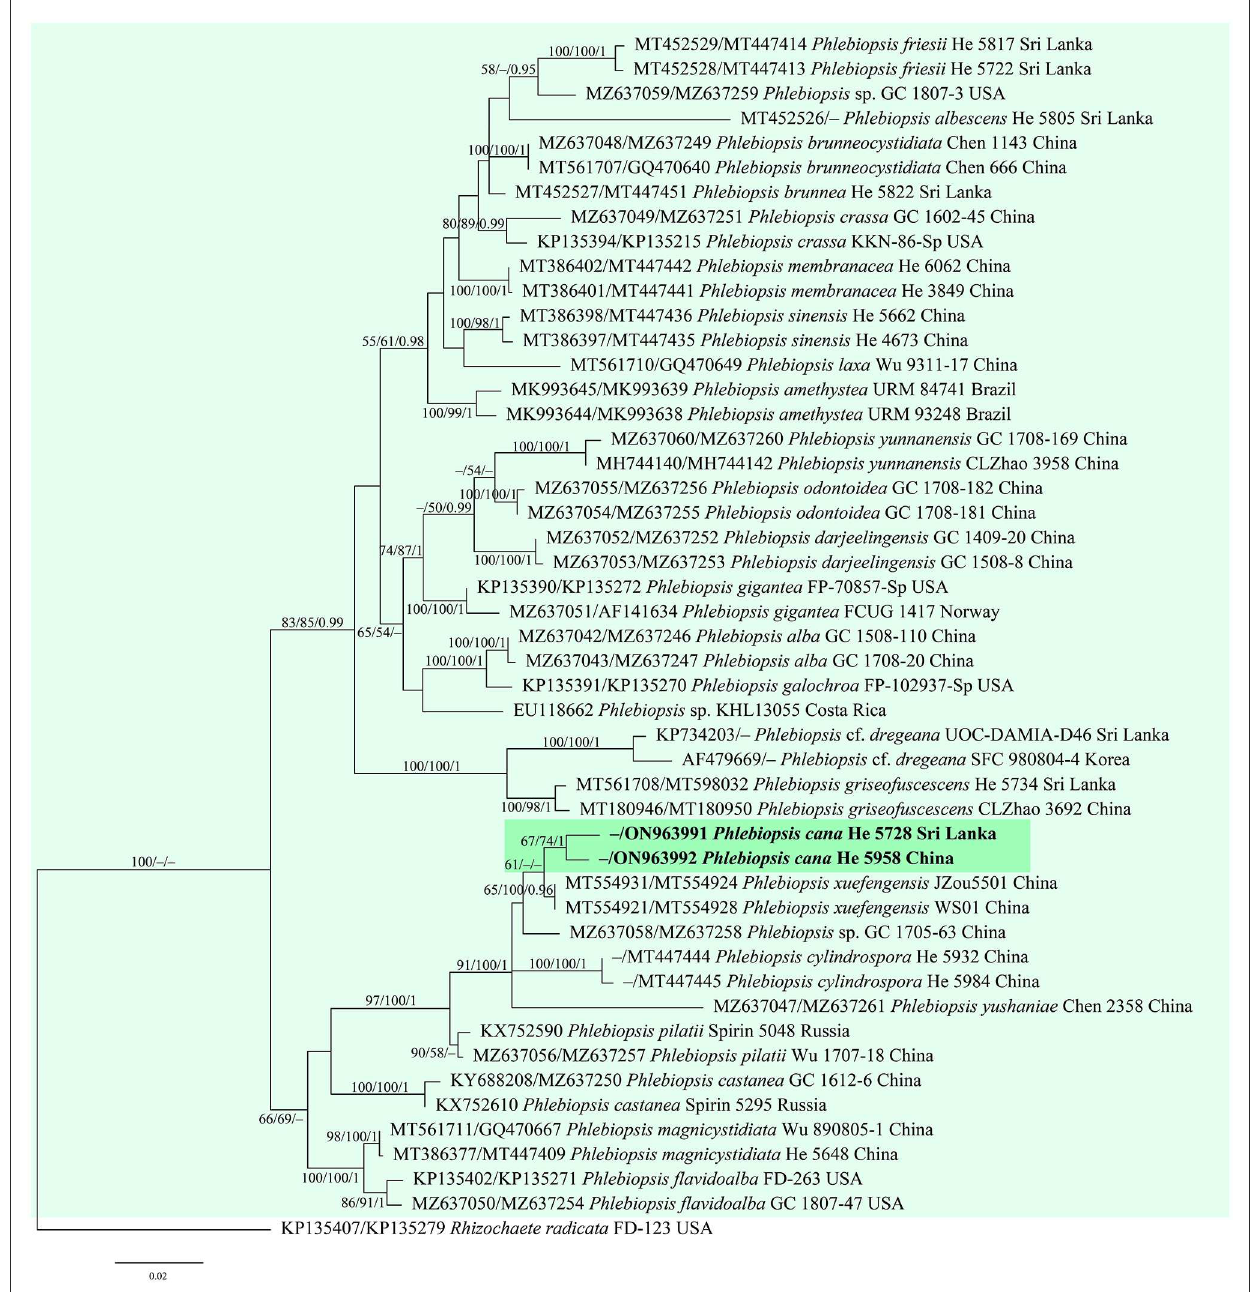
FIGURE2 Phylogenetic tree obtained from ML analysis of the ITS-nrLSU sequences of Phlebiopsis . Branches are labeled with parsimony bootstrap values ( ≥ 50%, first), likelihood bootstrap values ( ≥ 50%, second), and Bayesian posterior probabilities ( ≥ 0.95, third). The new species are set in bold and